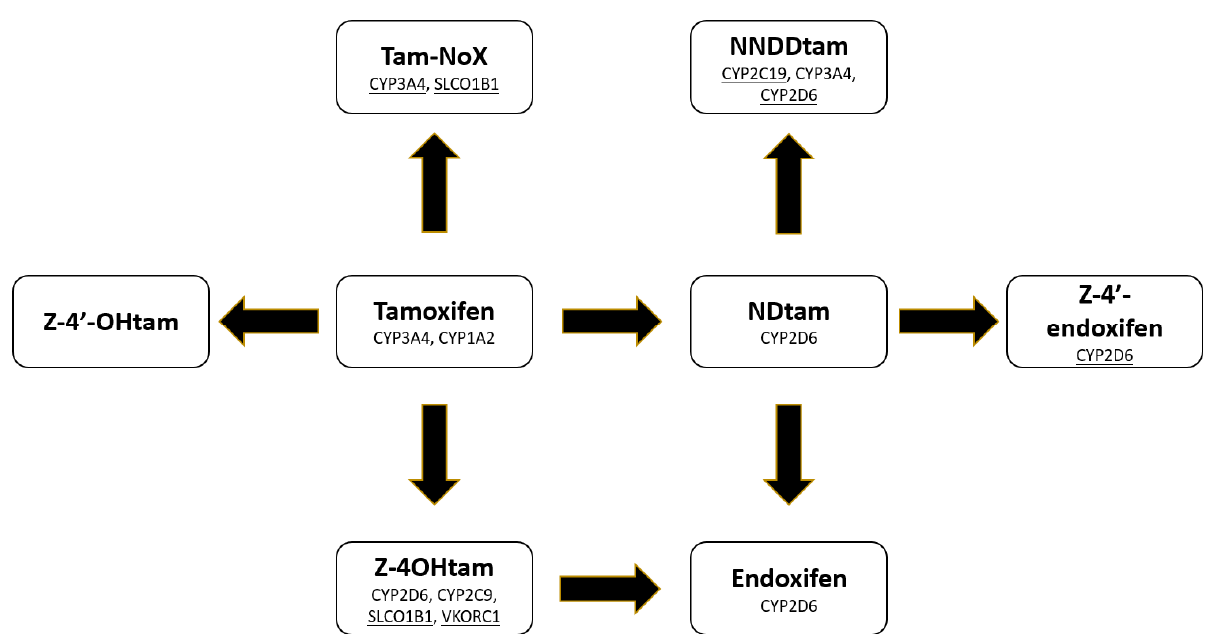
Figure 2. Tamoxifen metabolism pathway and genes associated with each step based on the results of this analysis. Genes associated with each metabolite are indicated within the figure. Normal text indicates our data confirm prior evidence of the gene’s contribution to this metabolic conversion [11,24], whereas underlined text indicates a finding that has not been previously described to our